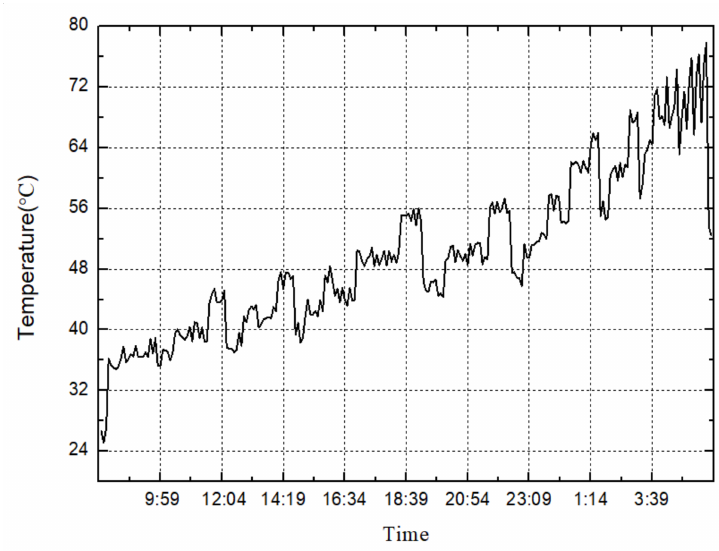
Figure 15. Temperature change curve in one cycle.